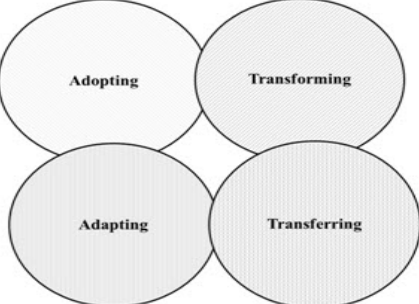
Figure 1. Phases of Transformative Ed-